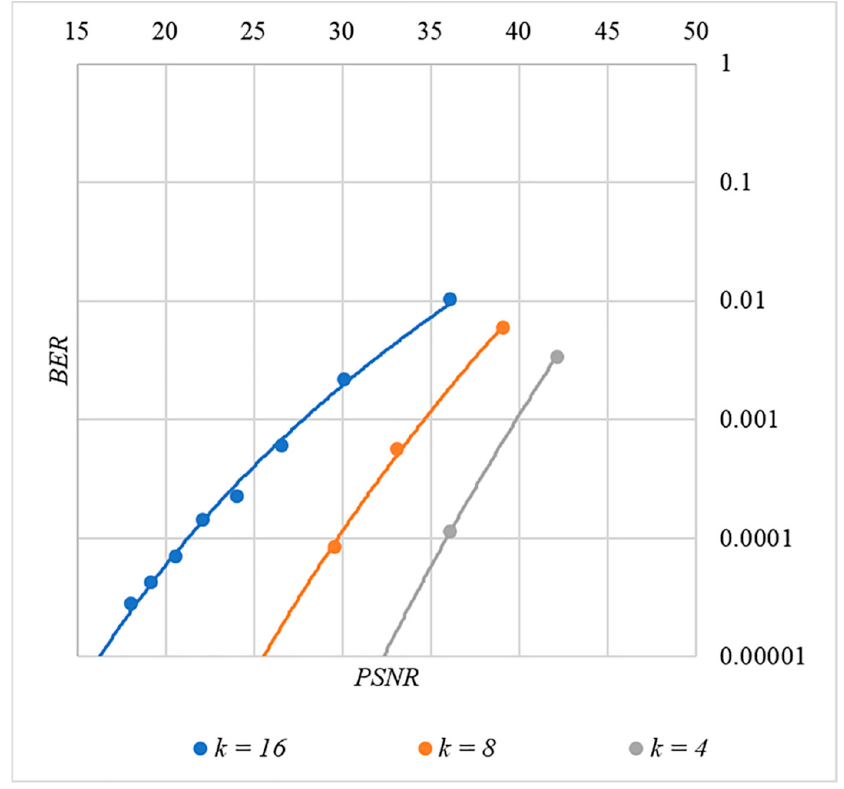
Figure 17. BER ( PSNR ) dependencies for different values k rule for generating chip codes № 5.